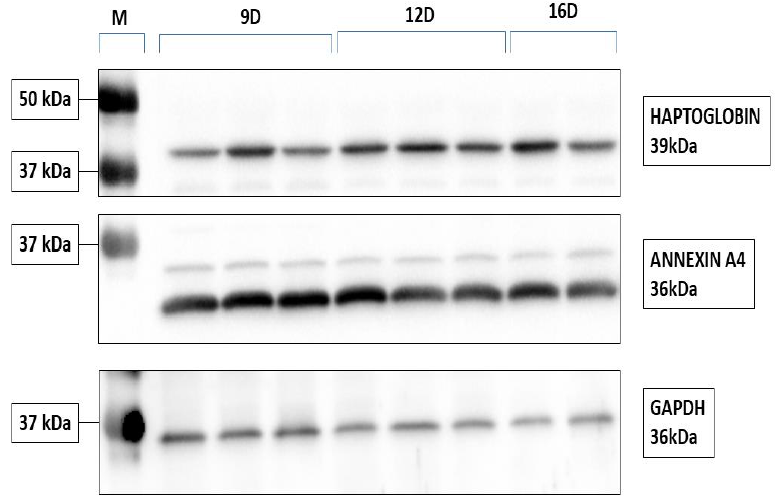
Figure 8. Representative validation of annexin A4 and haptoglobin by 1D western blot in the porcine endometrium at 9D, 12D, and 16D of early pregnancy in PLW gilts.